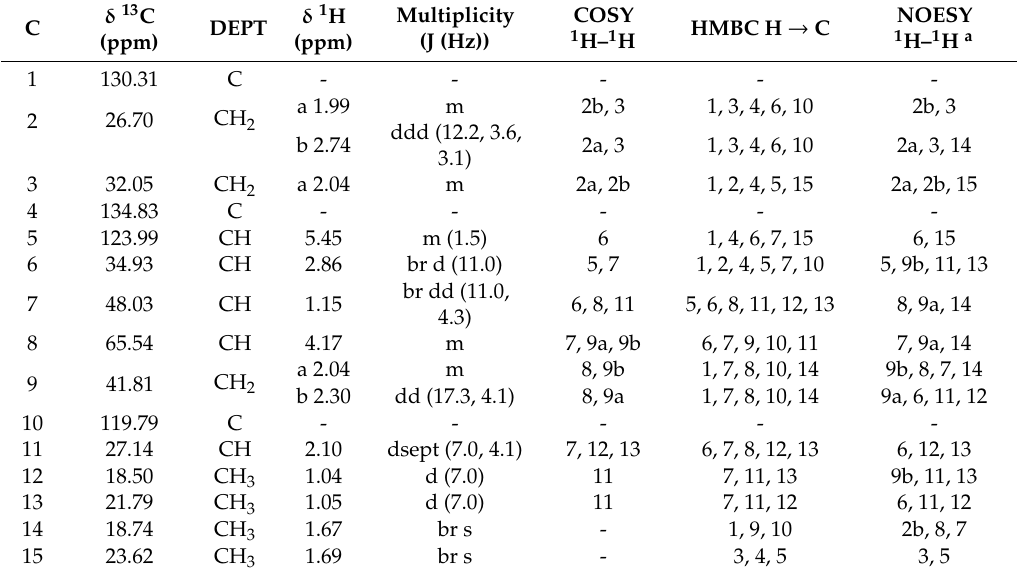
Table 3. NMR data of compound 56 .